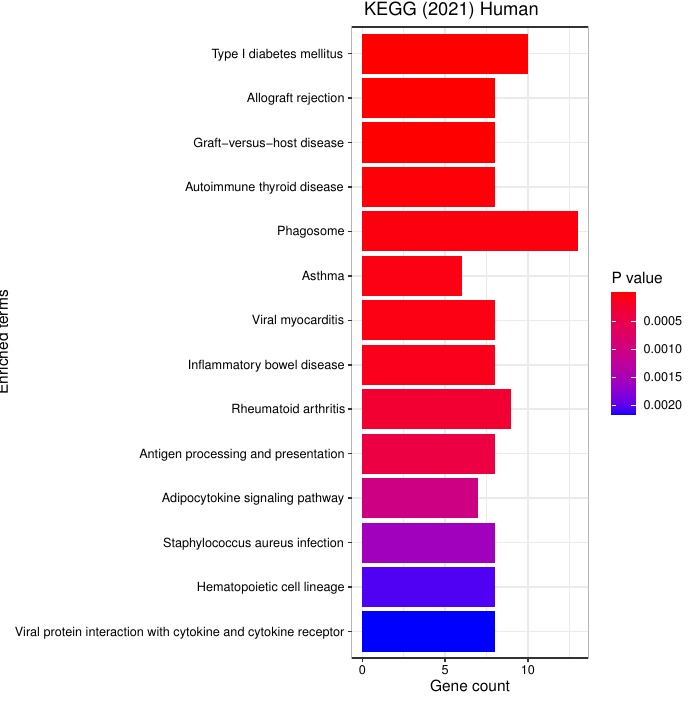
Figure 7. List of all the KEGG pathways that are enriched in the selected genes with the respective number of genes belonging to each term. The analysis was performed with enrichR at an FDR <